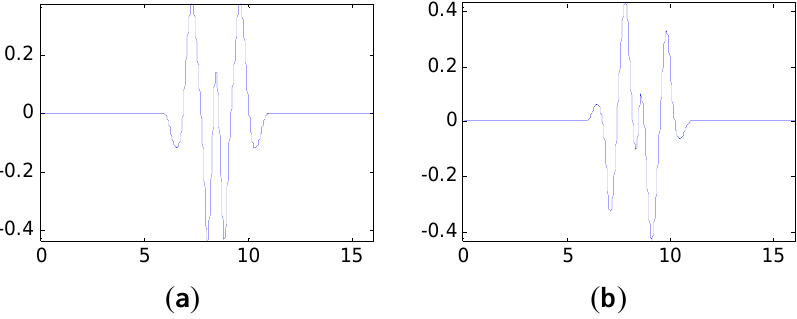
 and  constructed for vibration signal in case 1 2